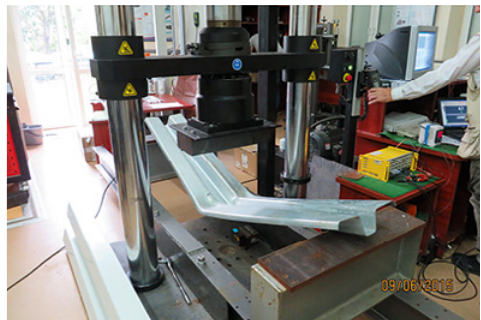
Figure 5. Final deformation of guide rail B